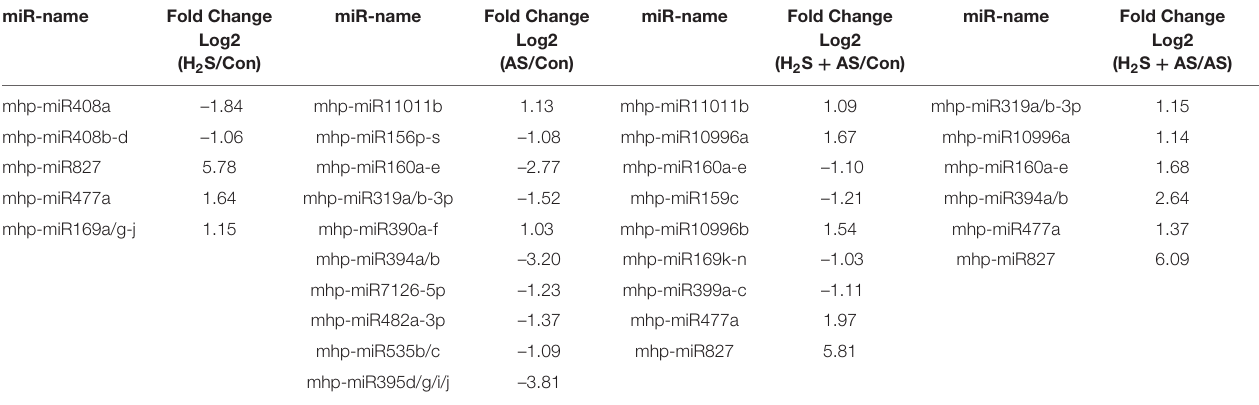
TABLE 1 | Differentially expressed miRNAs in H 2 S alleviate alkaline salt and alkaline salt stress in M. hupehensis roots.